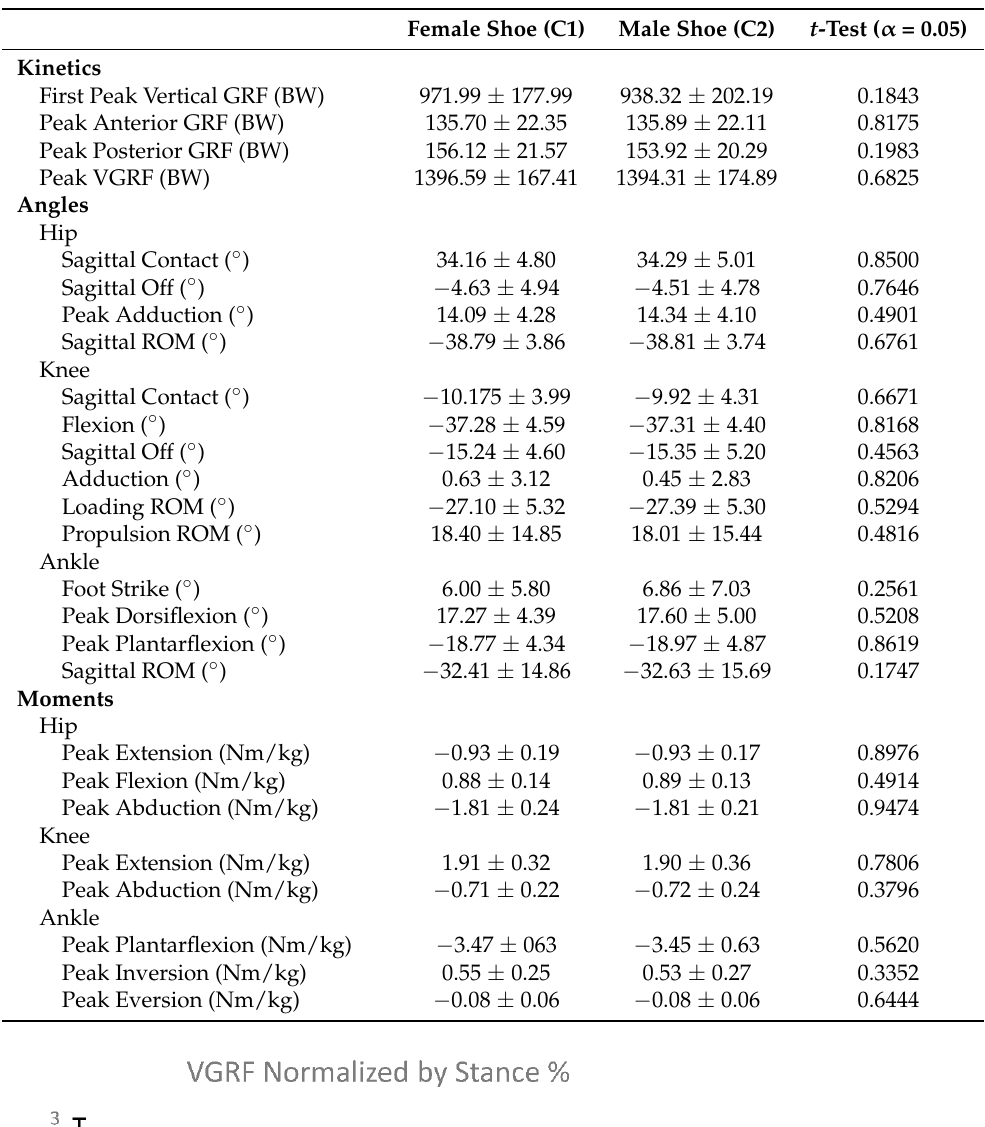
Table 1. Average dominant leg discrete biomechanical values. Data are presented as mean ± standard deviations with their associated p -values from the paired t -test ( α = 0.05).